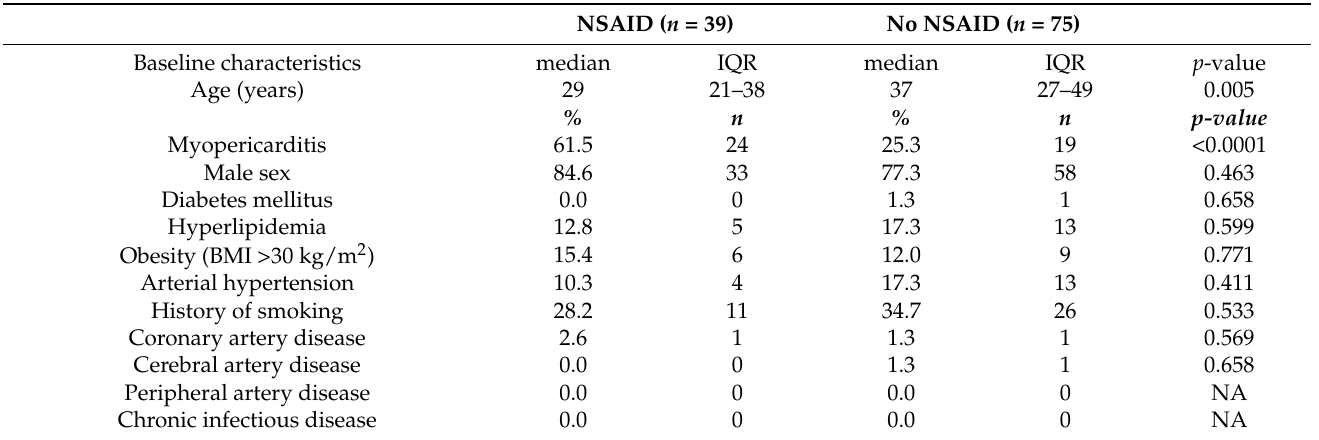
Table 1. Baseline characteristics, laboratory data and data from ECG and TTE of patients enrolled in the study. NSAID ( n = 39) No NSAID ( n =